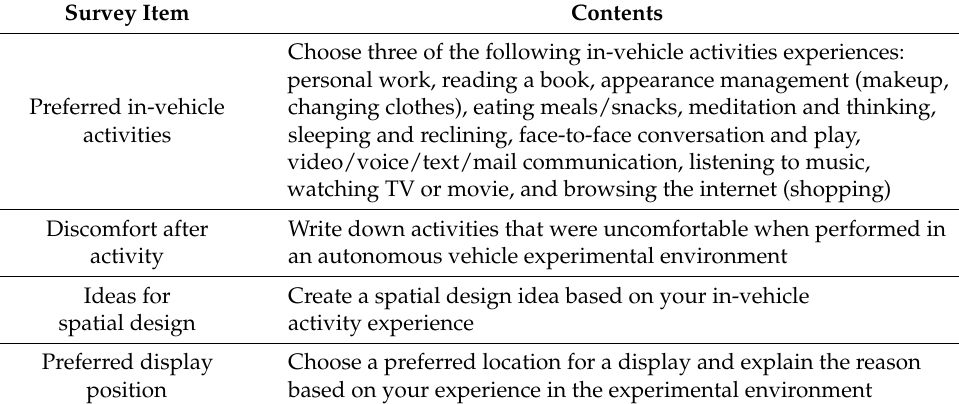
Table 3. Contents of the